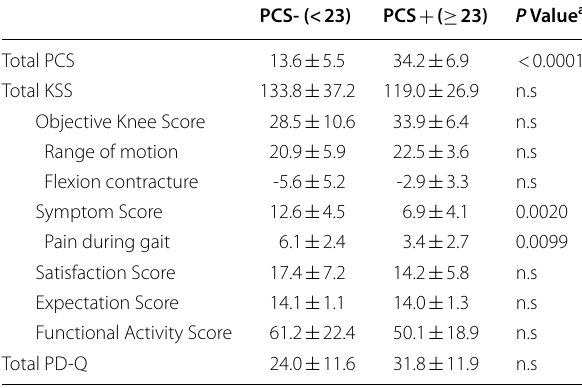
Table 3 Clinical score and patient-reported assessment in each group based on PCS (mean ±